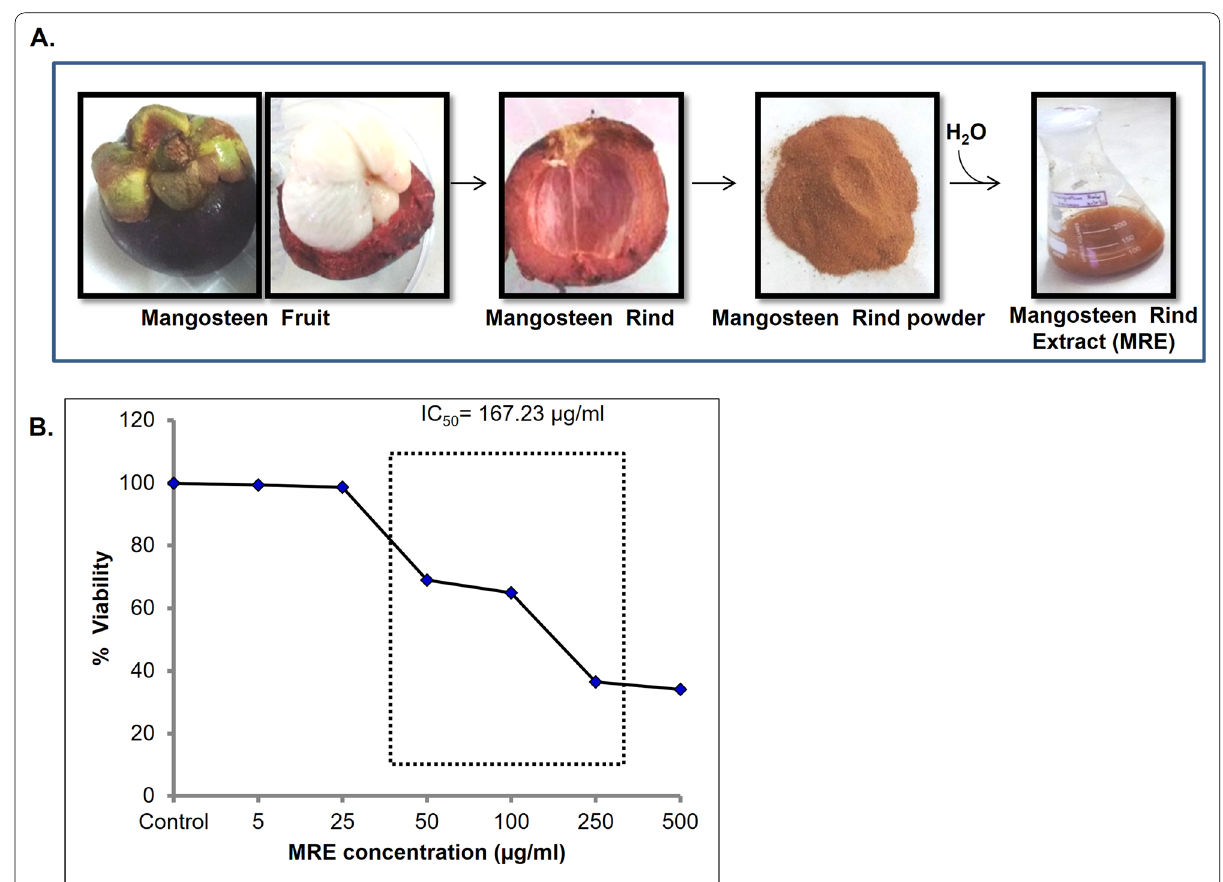
Fig. 1 Preparation and cell sensitivity analysis of mangosteen rind extract (MRE). A Preparation of mangosteen rind extract (MRE). From whole mangosteen fruit, rind was separated, dried, and powdered. Five percent (w/v) extract was prepared with autoclaved distilled water, purified, and used for further analyses. Pictures showing the parts in the extraction process are: mangosteen fruit (whole and inner pulp), rind, mangosteen rind powder, and mangosteen rind extract (MRE). B Viability assay on MCF7 cells. Sensitivity of MCF-7 cells to different concentrations of MRE were analyzed by MTT assay. The results are expressed as percentage of viable cells in the treatment by comparing with the number of viable cells in